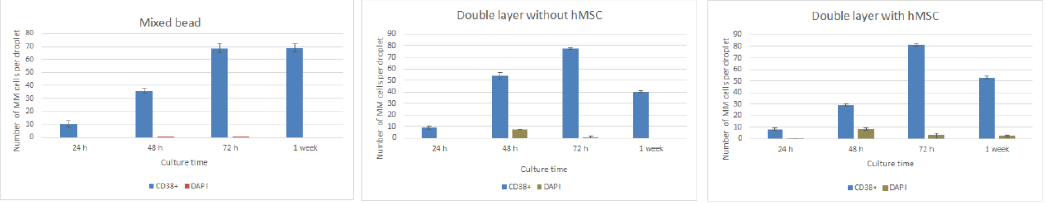
Figure 4. Number of FITC CD38 + and DAPI cells for the studied cases. From left to right: counted cells for mixed beads, double layered beads without MSCs and Double layered beads with MSCs. Beads were maintained in culture for two weeks performing three media changes per week.